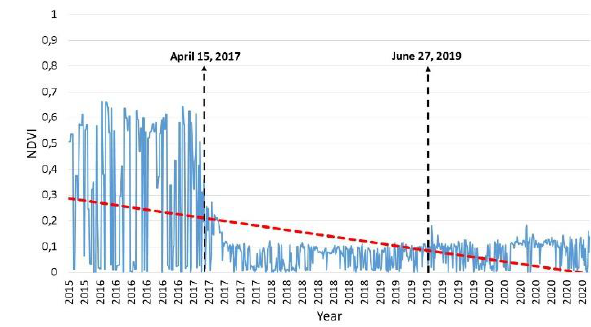
Figure 5. Sentinel-2 2015-2020 GEE NDVI time series.